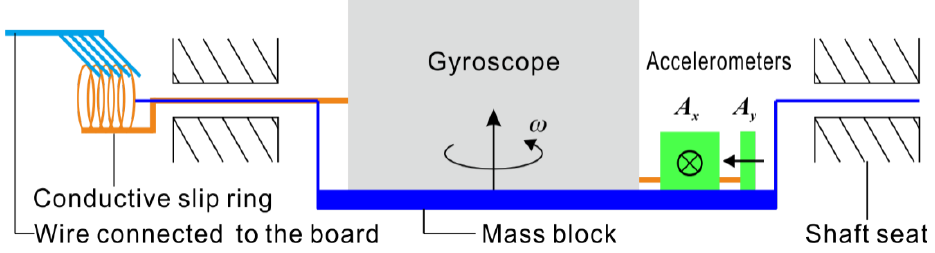
Figure 5. Schematic diagram of gravity stabilization platform.